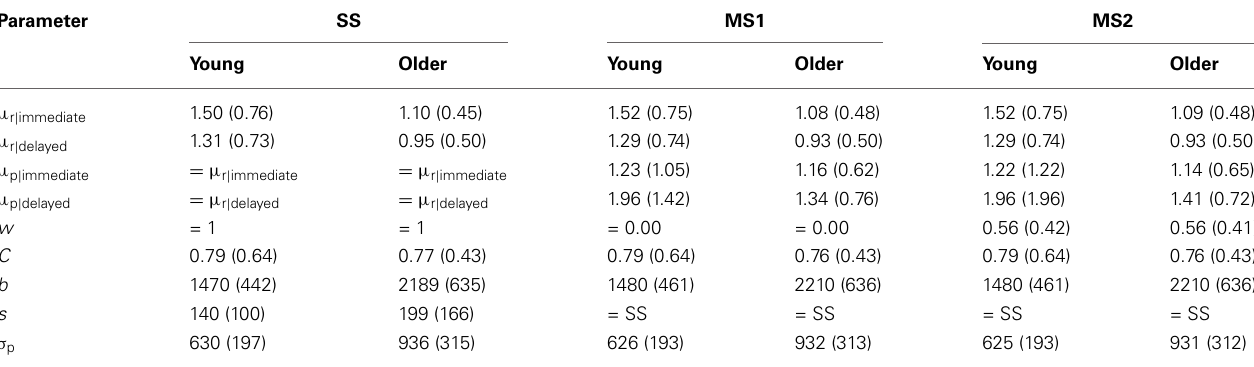
Table 2 | Mean and standard deviation (in parentheses) of the parameter estimates of the models (derived by maximum likelihood